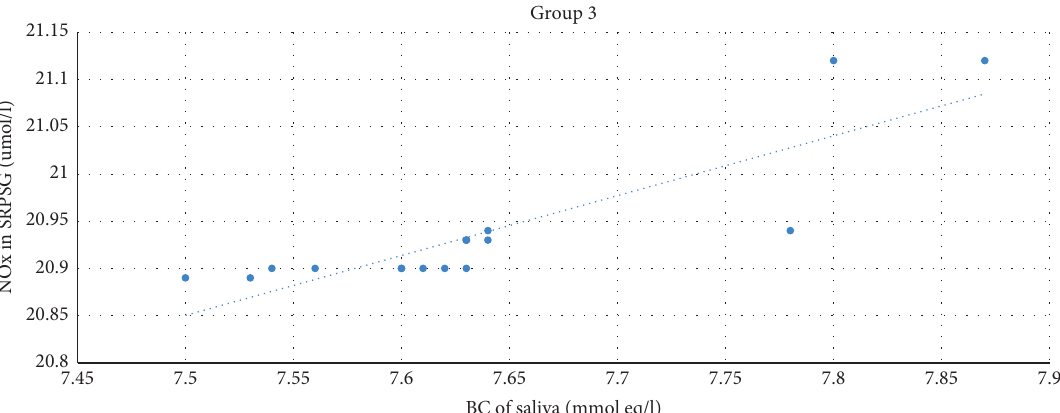
Figure 10: The correlation between the NOx level in SRPSG and the buffer capacity of saliva among patients in Group